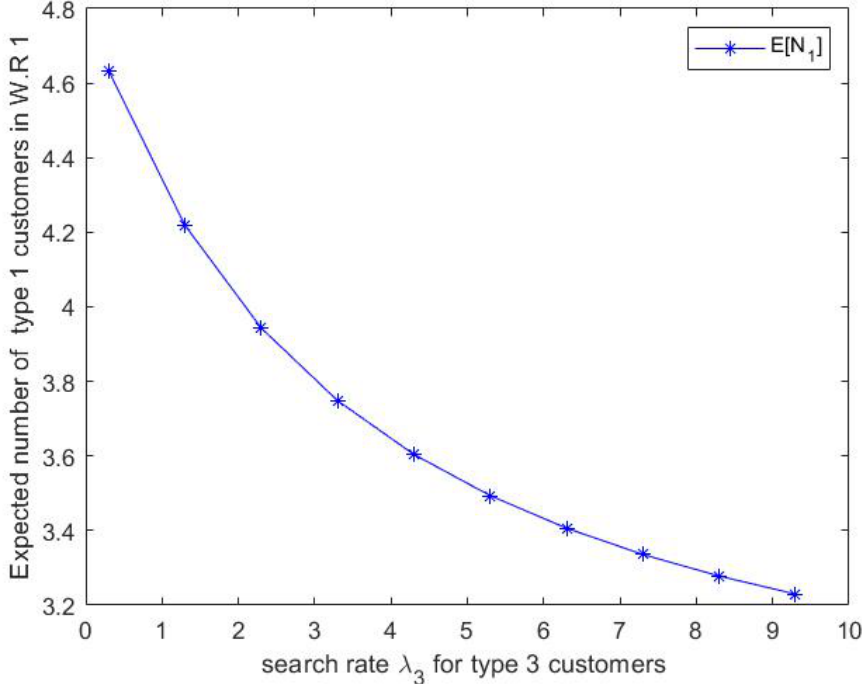
Figure 11. Effect of λ 3 on expected number of type 1 customers in waiting room